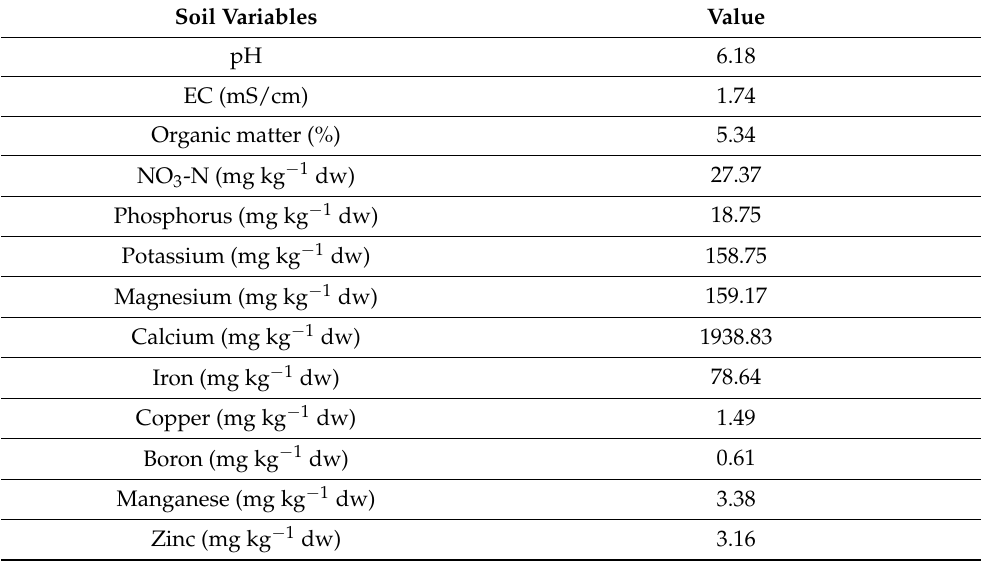
Table 1. The physicochemical properties of the cultivation area. Soil